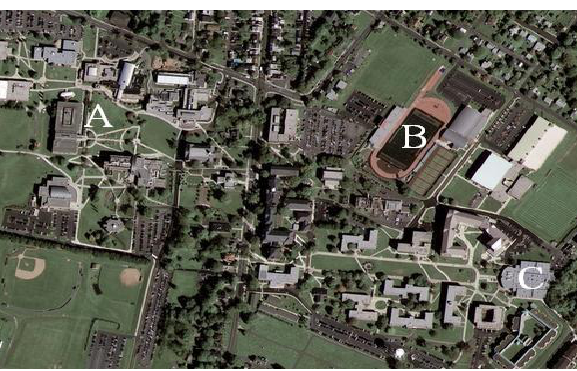
Figure 4. Experiment of Remote Sensing Images High level users can get respective encryption key of confidential area by calculating with their own keys then decipher the encrypted image of area (b),(d)and (f) to get complete information . By the same method ,secondary users can get information of area (d) 、 (f) but (a) while the ordinary users cannot get any keys of confidential area but the indistinct image of area (b),(d)and (f)